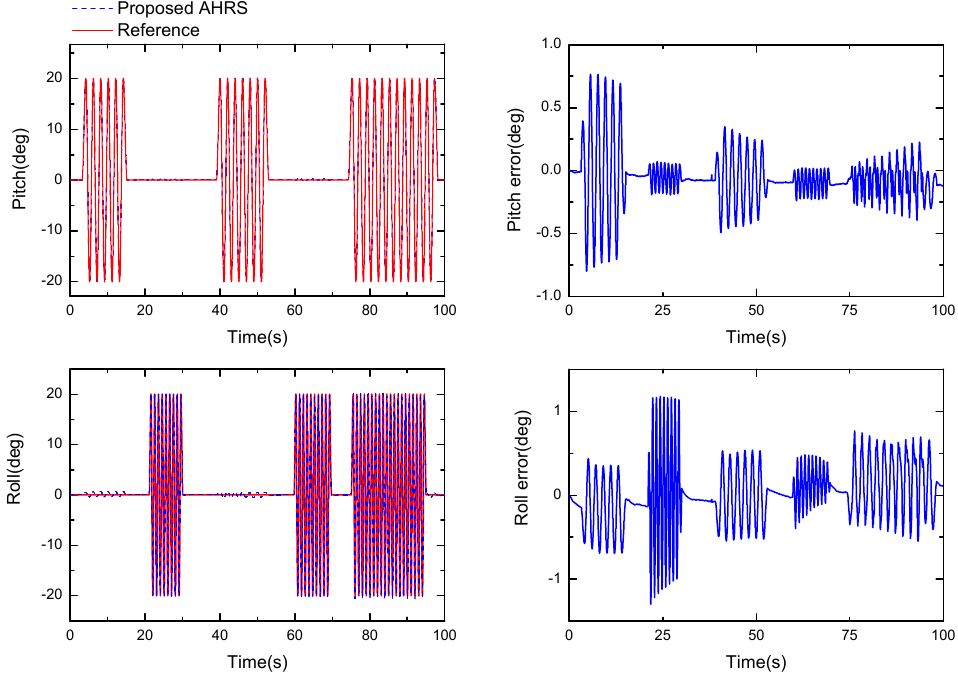
Figure 13. Orientation estimate produced by the proposed algorithm ( left , µ a = 0.005) and the difference between the estimate and reference ( right